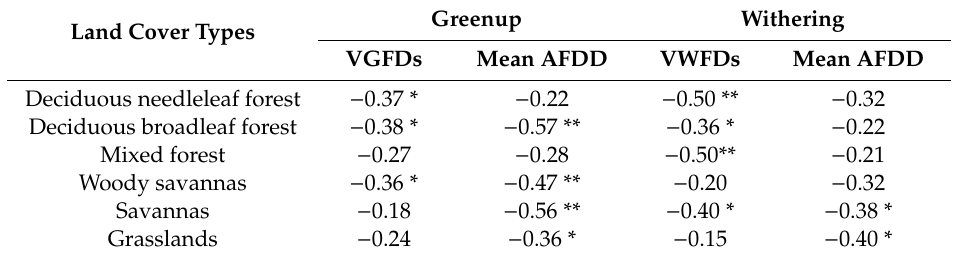
Table 1. Partial preseason correlation (R p ) between Vgreenup (Vwithering) and frost for di ff erent land cover types in Northeast China. Greenup Withering Land Cover Types VGFDs Mean AFDD VWFDs Mean AFDD Deciduous needleleaf forest − 0.37 * − 0.22 − 0.50 ** − 0.32 Deciduous broadleaf forest − 0.38 * − 0.57 ** − 0.36 * − 0.22 Mixed forest − 0.27 − 0.28 − 0.50** − 0.21 Woody savannas − 0.36 * − 0.47 ** − 0.20 − 0.32 Savannas − 0.18 − 0.56 ** − 0.40 * − 0.38 * Grasslands − 0.24 − 0.36 * − 0.15 − 0.40